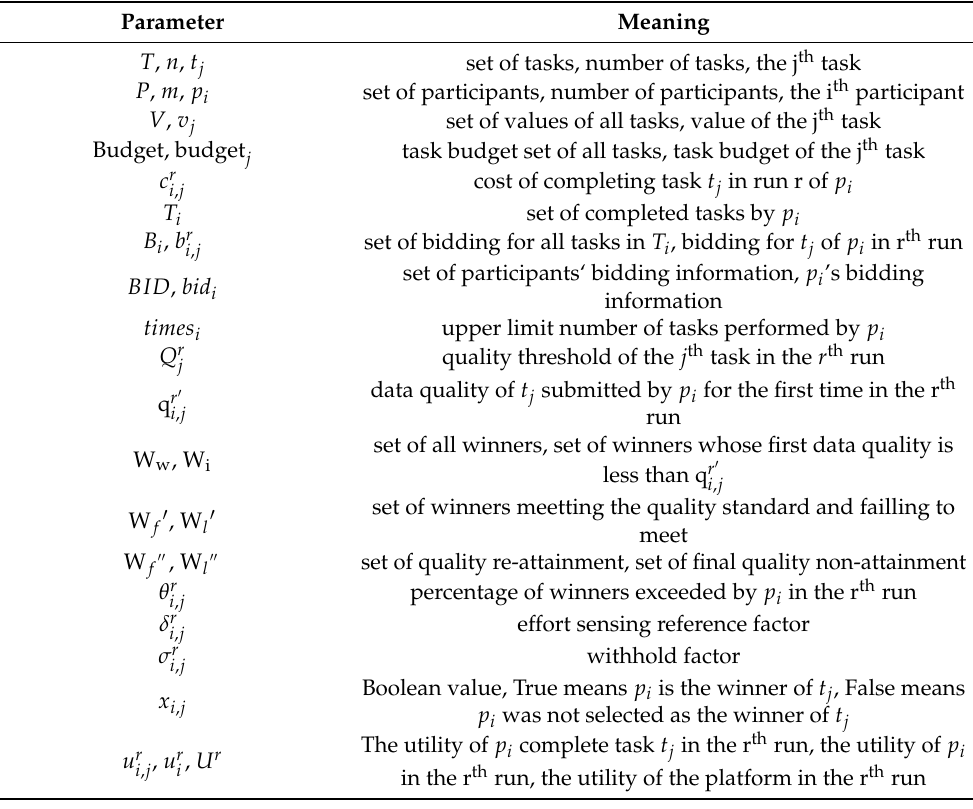
Table 1. Common parameters and their